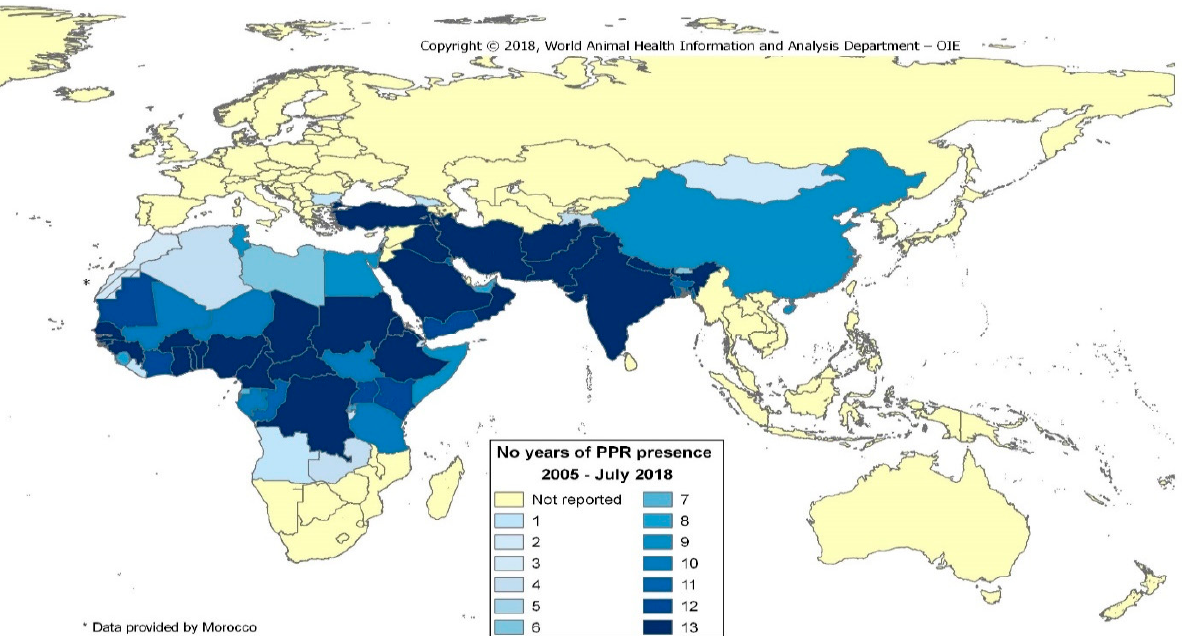
Figure 1. Length of PPR’s presence in years from 2005 to 2018 around the world. Source: World Animal Health Organization. https://www.oie.int/en/disease/peste-des-petits-ruminants/ accessed on 20 June 2021.